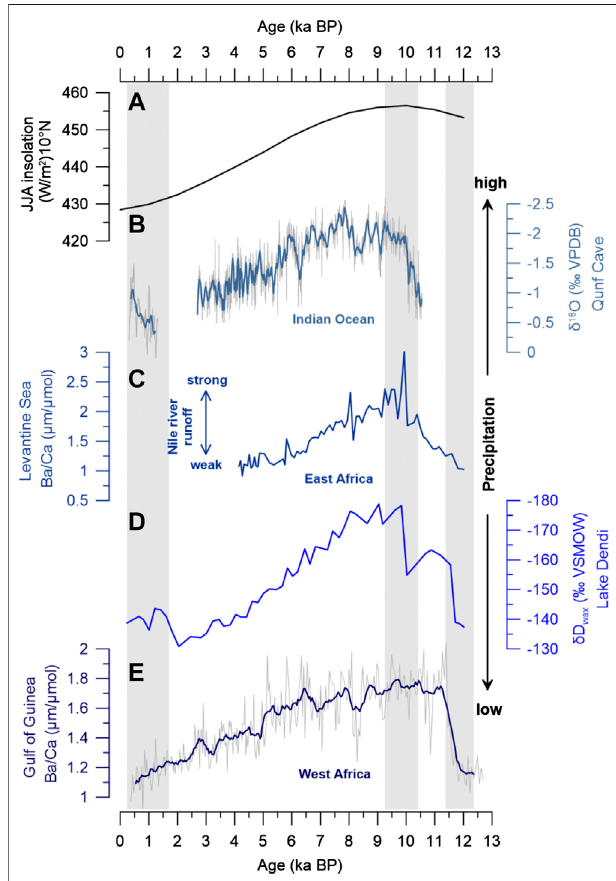
FIGURE 5 | Comparison with monsoon precipitation records. (A) Mean JJA insolation at 10 ° N (Berger and Loutre, 1991). (B) Stalagmite δ 18 O record from Oman indicating changes in Indian Summer Monsoon (Fleitmann et al., 2003). (C) Ba/Ca record from the Levantine Basin indicating changes in Nile River discharge related to East African Monsoon rainfall (Weldeab et al., 2014). (D) Lake Dendi δ D wax record indicating changes in rainfall in the Ethiopian highlands (this study). (E) Ba/Ca record from the Gulf of Guinea indicating changes in river runoff draining the West African Monsoon area (Weldeab et al., 2007). Vertical gray bars mark abrupt changes in the monsoon systems based on the different proxies.